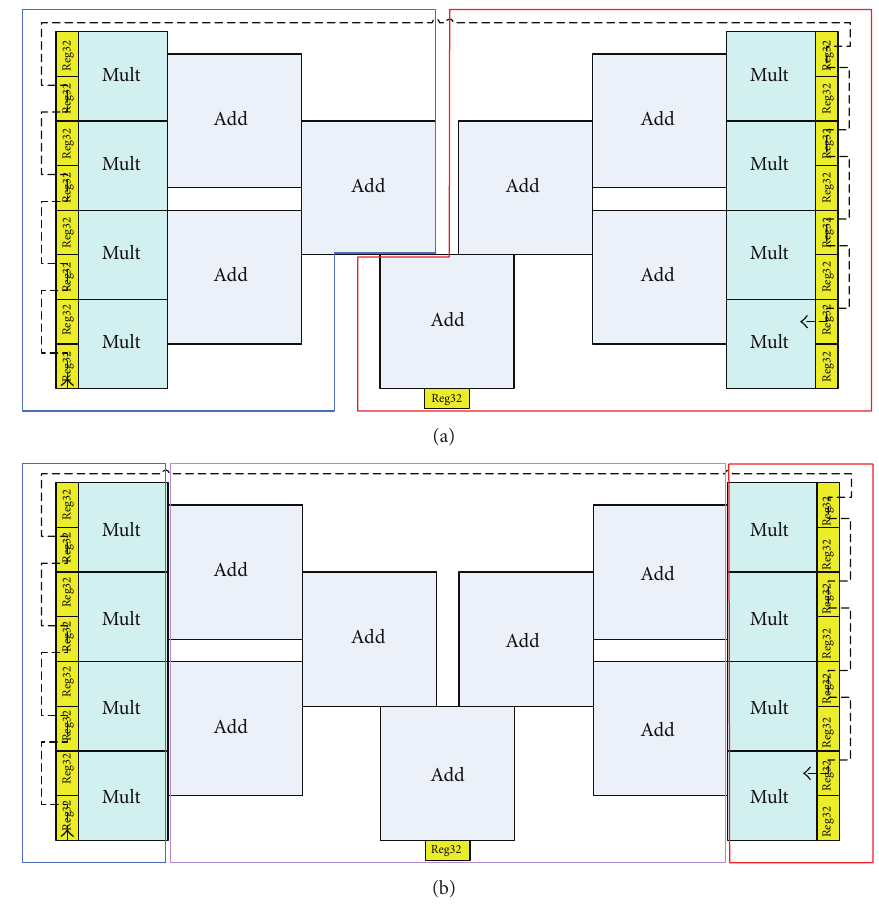
Figure 10: Placement and partitioning of 8-tap FIR filter on Stratix-II S180 into (a) two regions and (b) three regions.